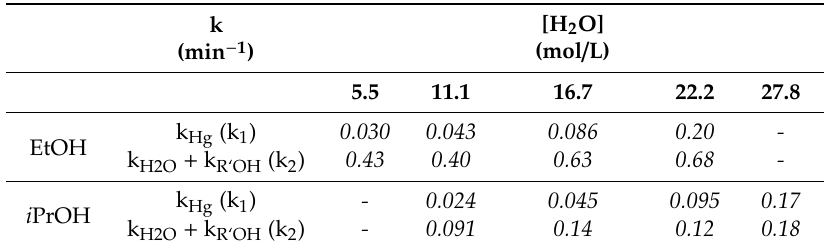
Table 2. The pseudo first-order rate coe ffi cients for the reaction of 1,5-ICAN with water in di ff erent water / protic co-solvents mixtures and HgCl 2 . The errors of the obtained rate coe ffi cients were within ± 10%. Experimental conditions: [1,5-ICAN] = 2.5 × 10 − 6 mol / L, [HgCl T = 25 ◦ C.